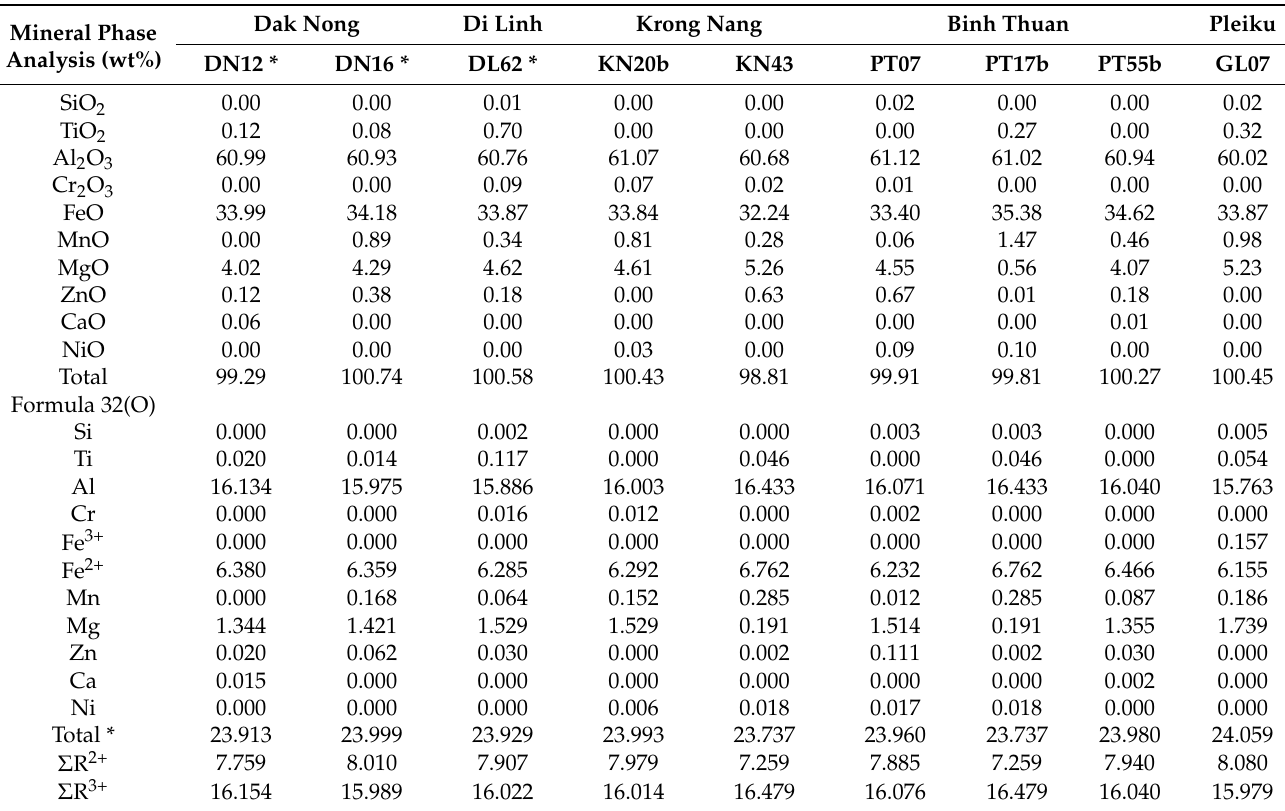
Table 2. Representative EPMA analyses of hercynite spinel inclusions in sapphire from Southern